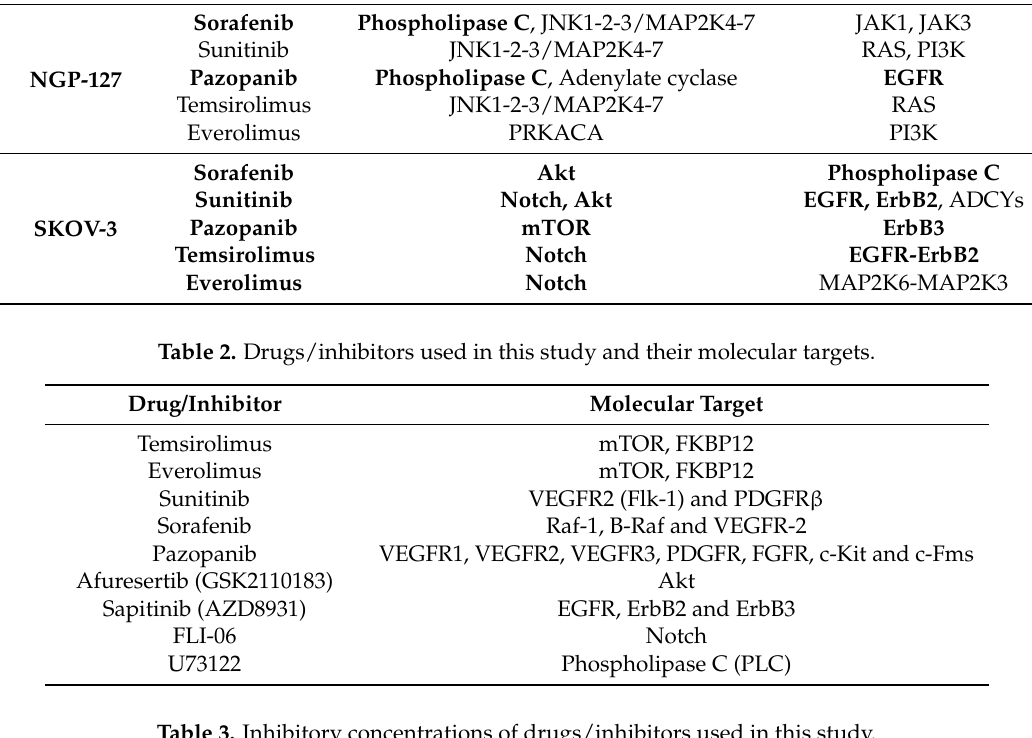
Table 3. Inhibitory concentrations of drugs/inhibitors used in this